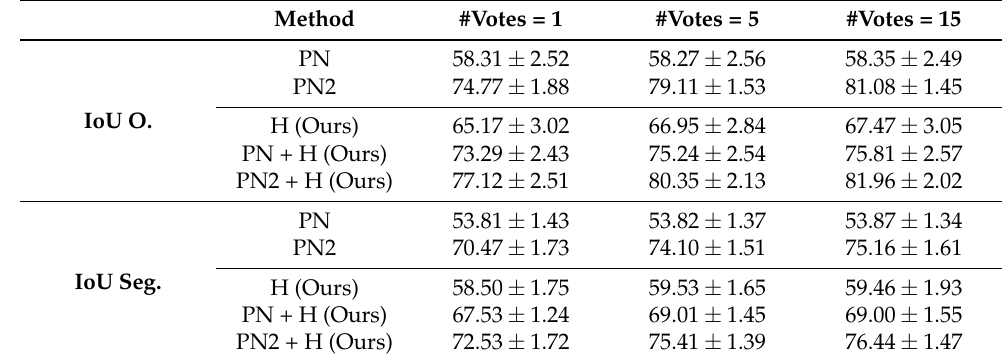
Table A2. Performance of the supervised point cloud semantic segmentation methods when varying the average number of votes during